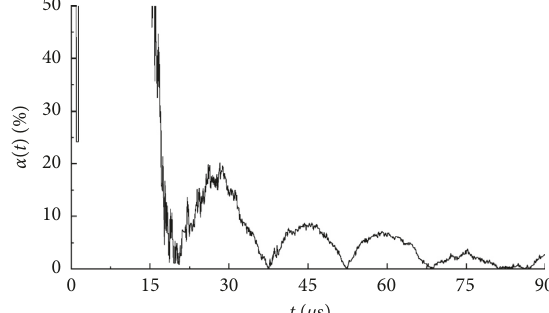
Figure 5: Time history of dimensionless stress nonuniformity